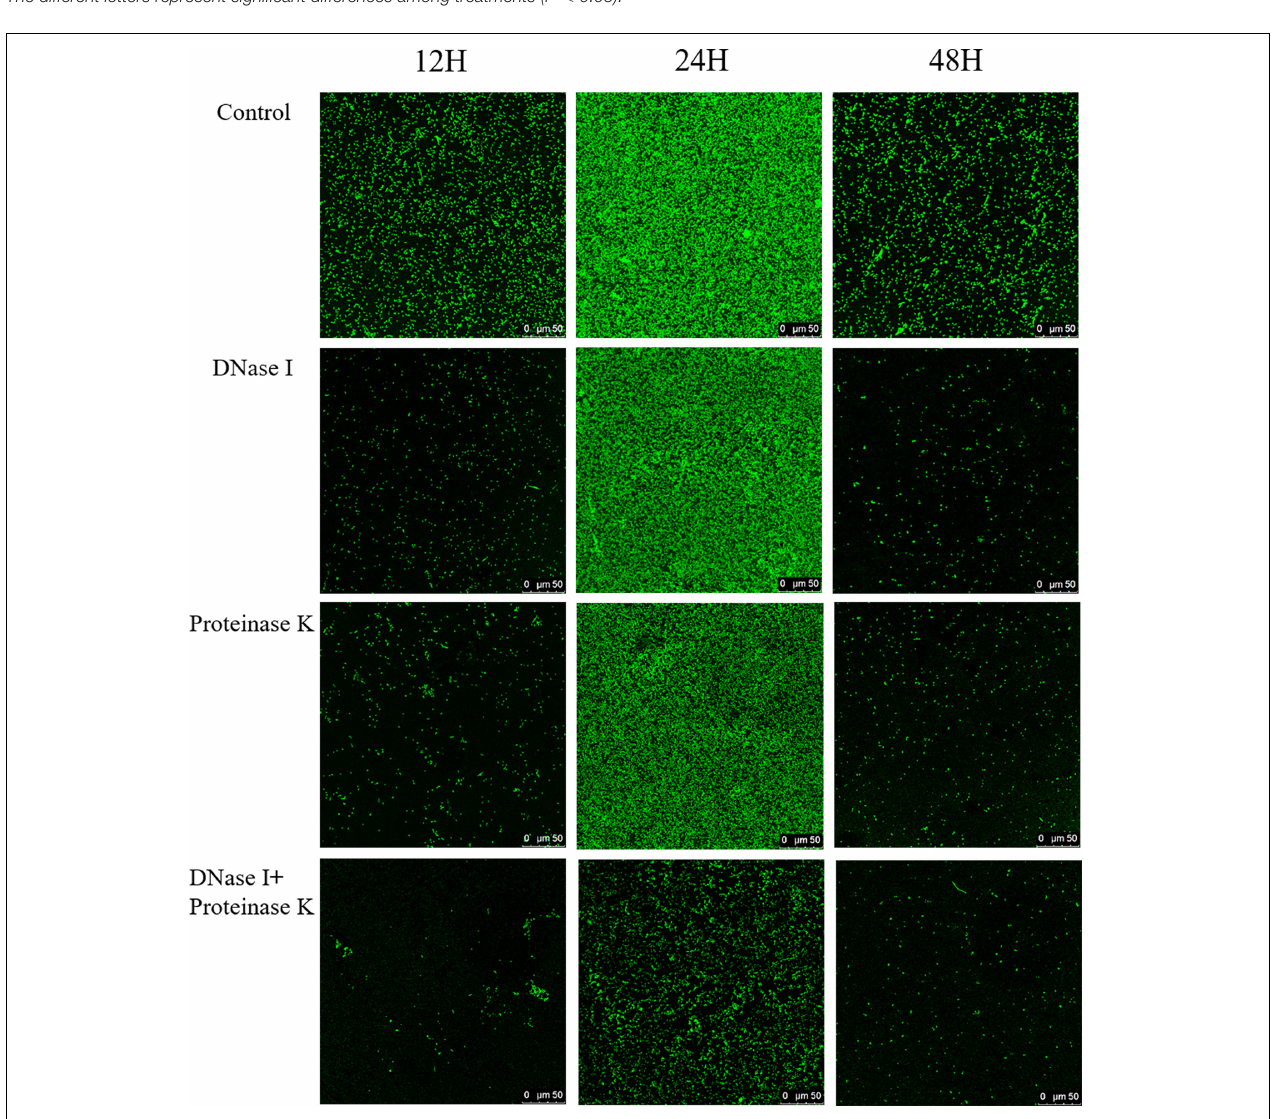
FIGURE 5 | Representative CLSM images of V. parahaemolyticus biofilms treated with DNase I, proteinase K, and their combination at 12, 24, and 48 h of cultivation. The scale bar represents 50 µ m. Pictures are representative of at least three individual scans from three independent experiments.